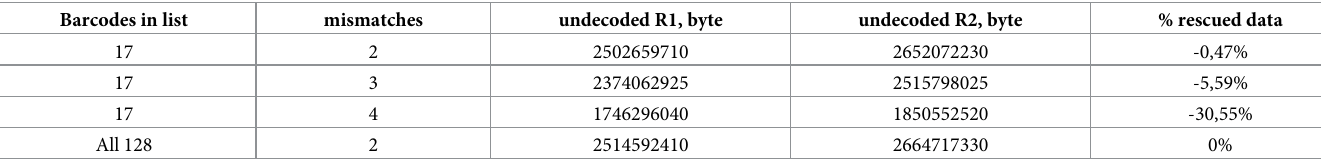
Table 1. The impact of the number of allowed mismatches in the bar code on the proportion of saved data from undecoded. Barcodes in list